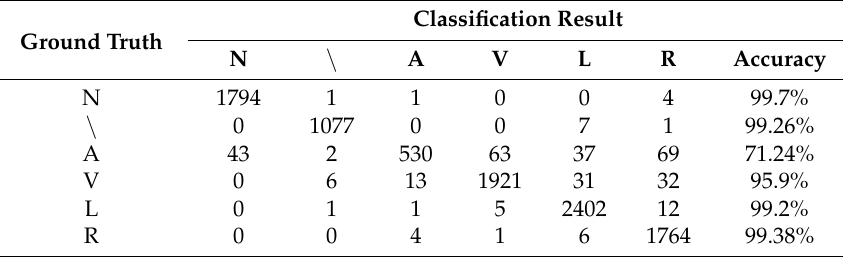
Table 4. Confusion matrix of the heartbeat classification results for the testing beats for the proposed method.